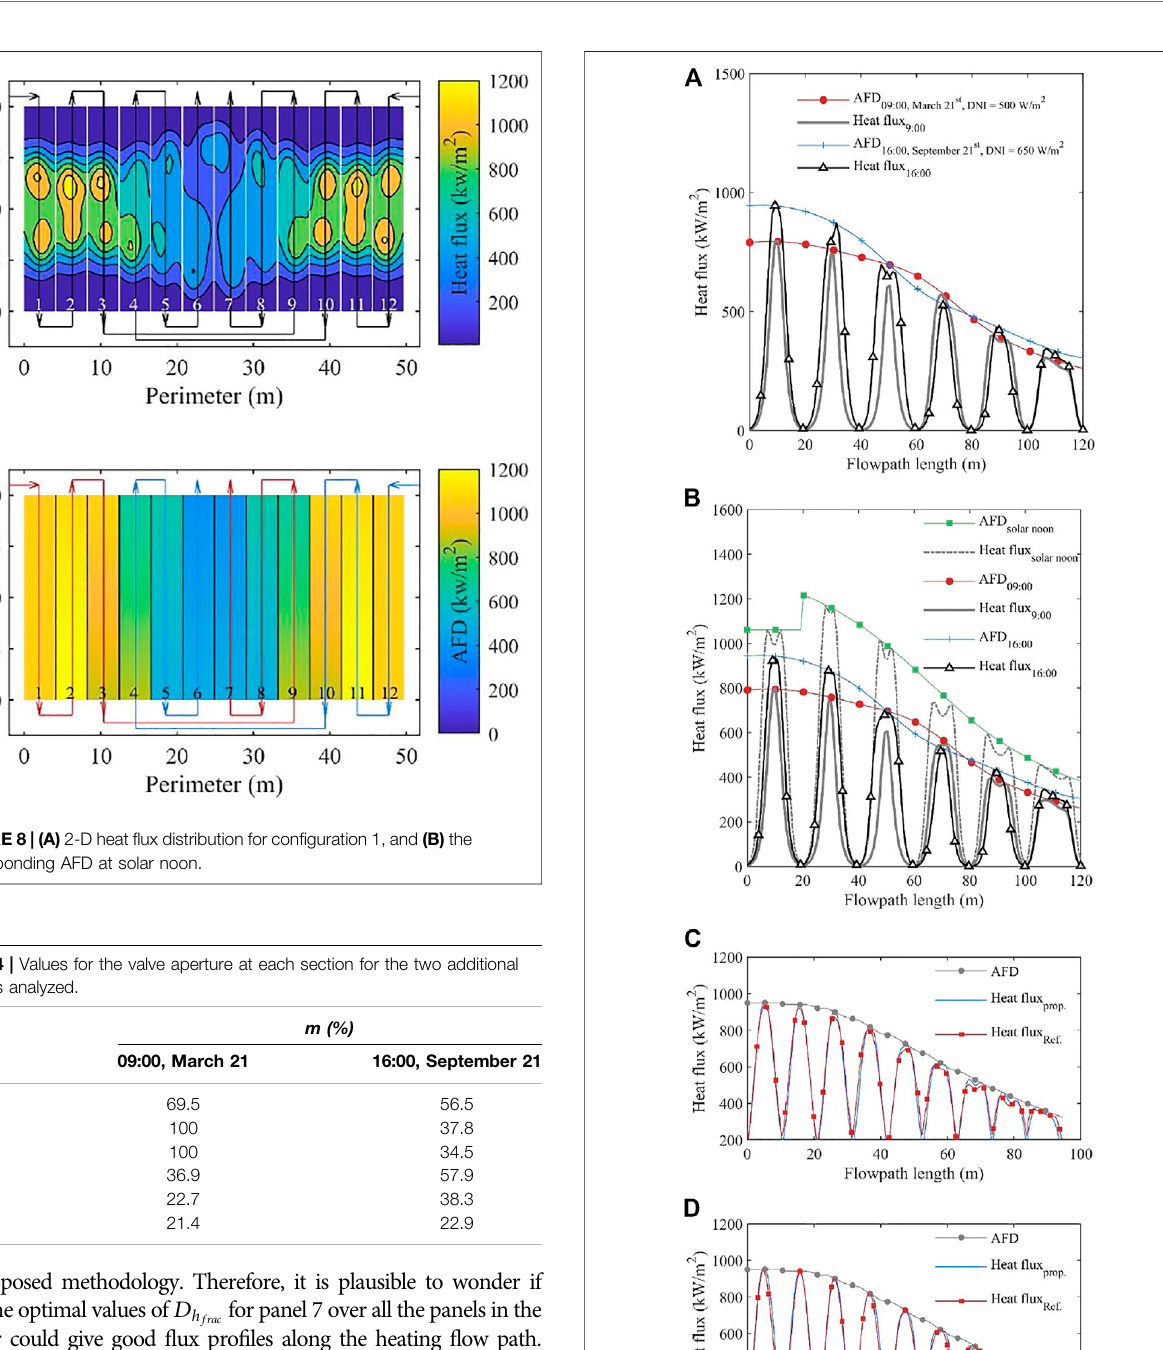
FIGURE 9 | (A) Performance of the aiming strategy under different scenarios for DNI and time (B) Performance of the aiming strategy under different scenarios for DNI and time, using the same values for D h sections as indicated in Table 5 (C) Comparison of the tuned aiming methodology to the results published by (Sánchez-González et al., 2016) (D) Comparison against the results given by (García et al.,